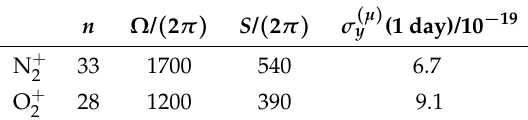
Table 2. Benchmark candidates for µ variation measurement. The upper vibrational states n that maximize the absolute sensitivities are calculated from molecular constants [52] and achievable precision for zero dead time, C = 0.6, an averaging time T = 1 day, and a coherence time of 6 s [53]. Ω / ( 2 π ) and S / ( 2 π ) are in units of THz. ( µ ) − 19 n Ω / ( 2 π ) S / ( 2 π ) σ y (1 day)/10 N + 33 1700 540 6.7 2 O + 28 1200 390 2